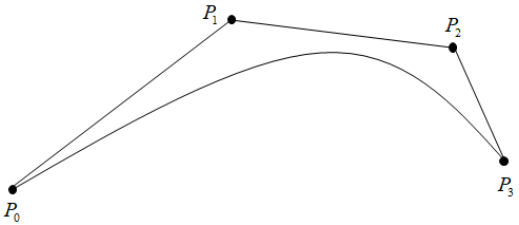
Figure 1. Convex hull diagram with four control points P 0 , P 1 , P 2 , P 3